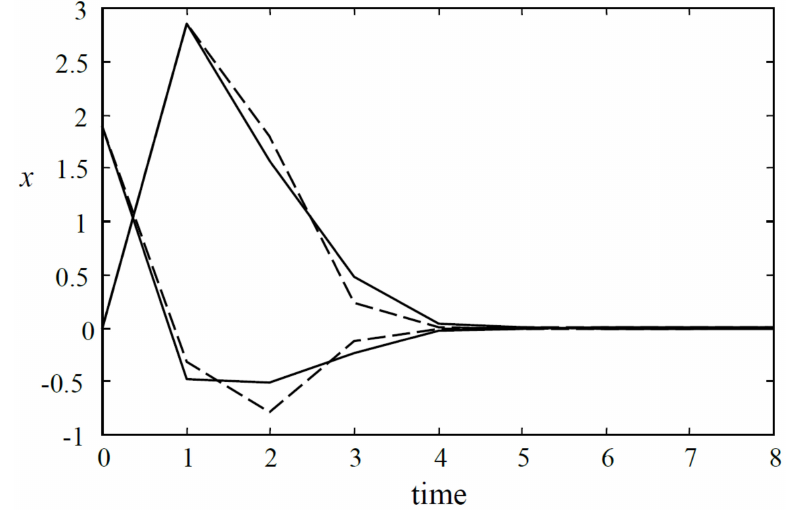
Figure 1. The state responses of the closed-loop systems (dashed line for Algorithm 1, solid Algorithm 2).